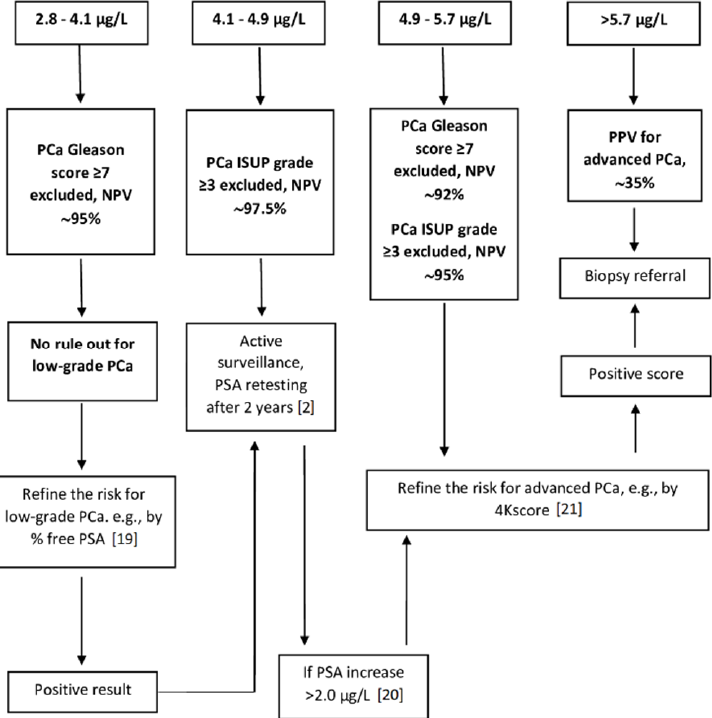
Figure 2. PSA—based diagnostic workup for patients < 65 years old, with no evidence of glandular inflammation on histology. This workflow includes recommendations on second level approaches inferred from the available literature (references reported in parentheses). The above values represent pre-biopsy serum PSA concentrations. In black, information derived by this study. Note: Recommended active surveillance implies PSA retesting after two years and it is stopped if the risk of advanced cancer increases according to an absolute PSA increase over 2 μ g/L. It is reasonable to endorse the PSA retesting interval recommended by the American Urological Association [2]. PCa, prostatic cancer; NPV, negative predictive value; ISUP, International Society of Urological Pathology; PPV, positive predictive value; 4Kscore, 4-kallikrein panel score.